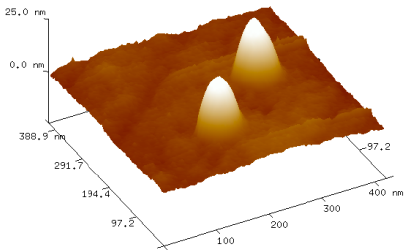
Figure 6. Exemplary picture of empty VLPs recorded using AFM tapping mode.